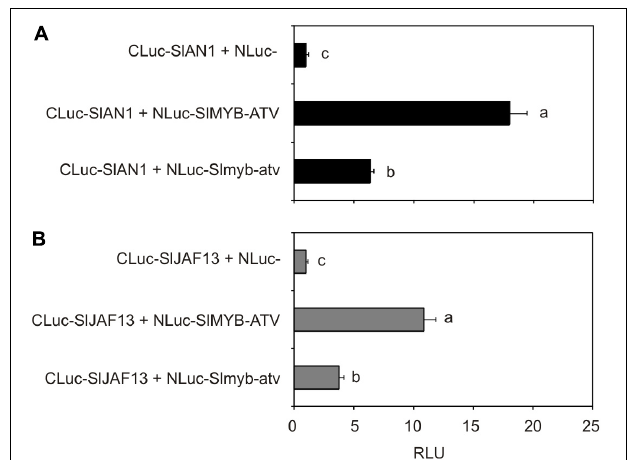
FIGURE 9 | SlMYB-ATV can interact with tomato bHLH factors involved in anthocyanin synthesis. Split-luciferase assays in MicroTom leaf protoplasts expressing the fusion proteins NLuc-SlMYB-ATV or NLuc-Slmyb-atv with CLuc-SlAN1 (A) or CLuc-SlJAF13 (B) . As a control, NLuc-half protein was expressed in combination with each of the two CLuc-SlAN1 (A) or CLuc-SlJAF13 fusion proteins (B) . Data are expressed as Relative Luciferase Activity (RLU) (RenillaLuc/protein content) and are means of four biological replicates ± SE. One-way ANOVA test (Tukey’s multiple comparisons test, P < 0.05) was carried out. Different letters indicate significant differences in each bar chart plot. Each experiment was repeated twice with similar